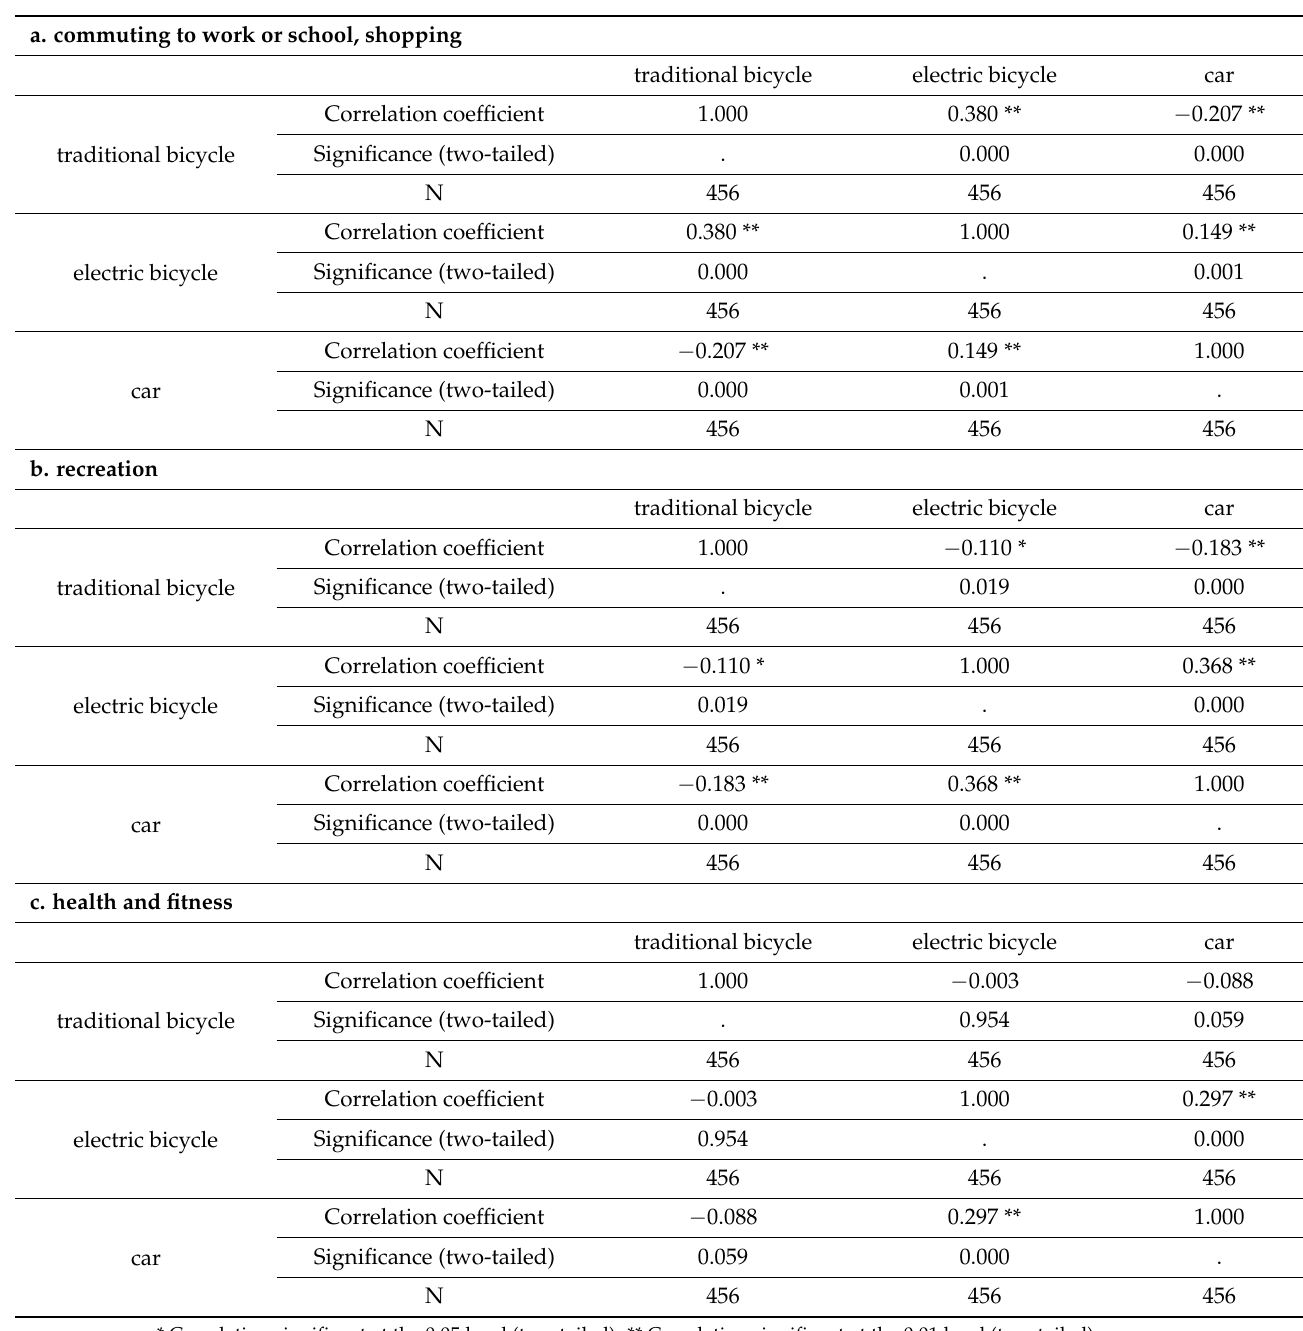
Table A3. Spearman correlation results for the different response options to the question: “Please rate the following means of transport in the aspects indicated (1—not suitable, 5—best